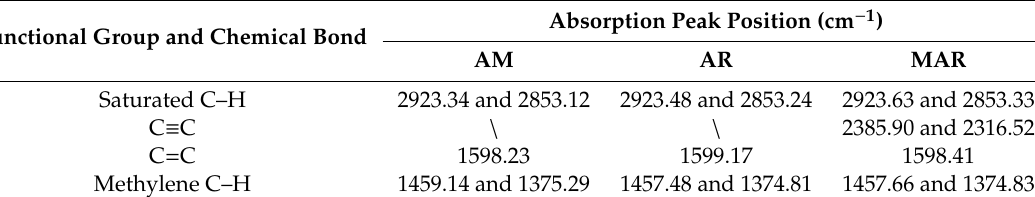
Table 7. Fourier transform infrared spectroscopy (FTIR) test results.